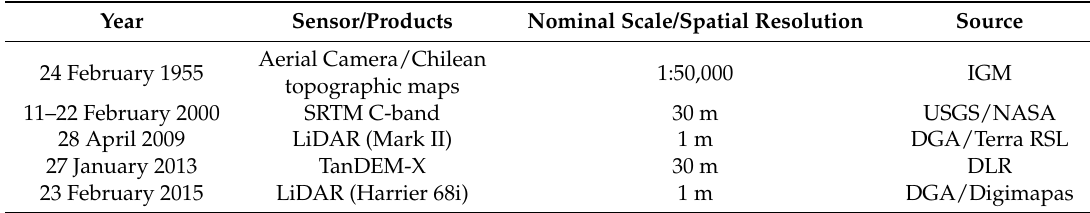
Table 2. Overview of the datasets used for glacier elevation